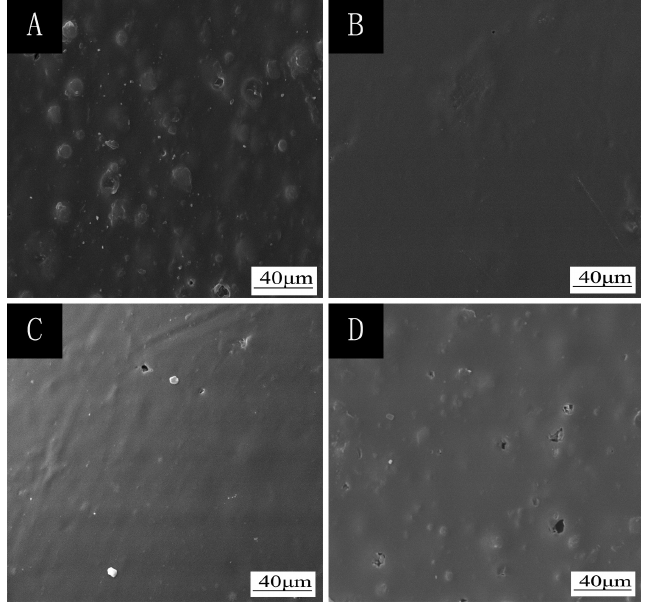
Figure 4. SEM images of the coatings of Samples #1–#4 ( A – D ).